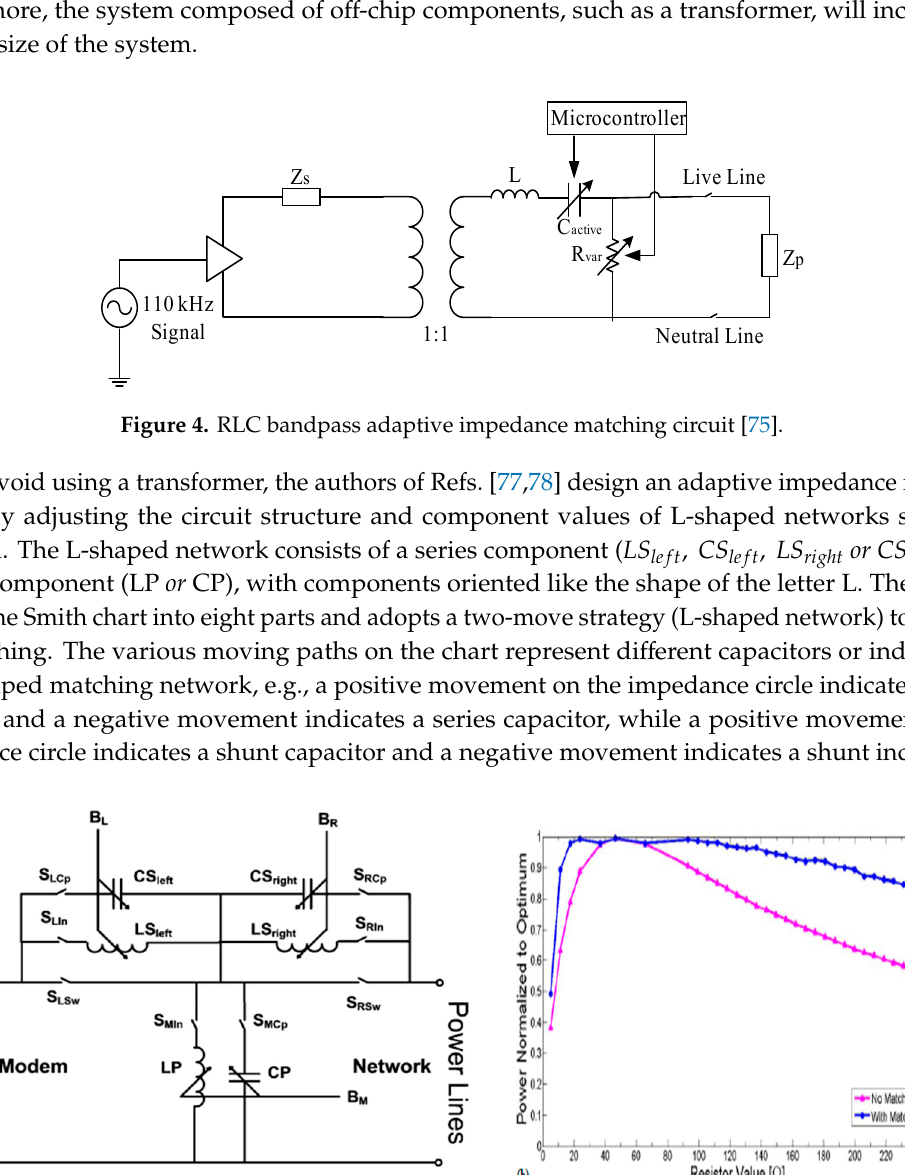
Figure 4. RLC bandpass adaptive impedance matching circuit [75].